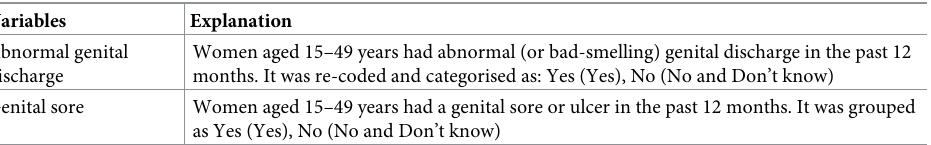
Table 1. Explanation of outcome